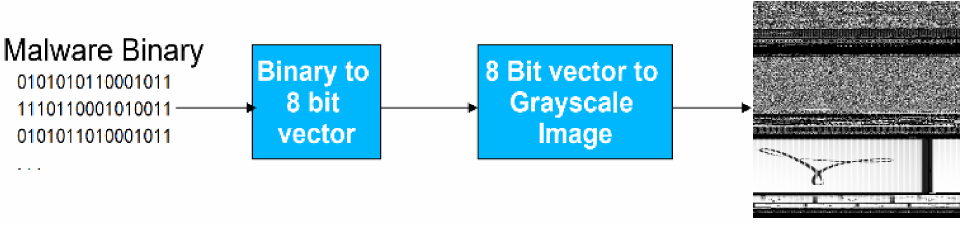
Figure 3. The process of visualizing malware as an image. Malware byte files are converted into 8-bit vectors, and then reshaped to two-dimensional arrays, at last saved as three-channel